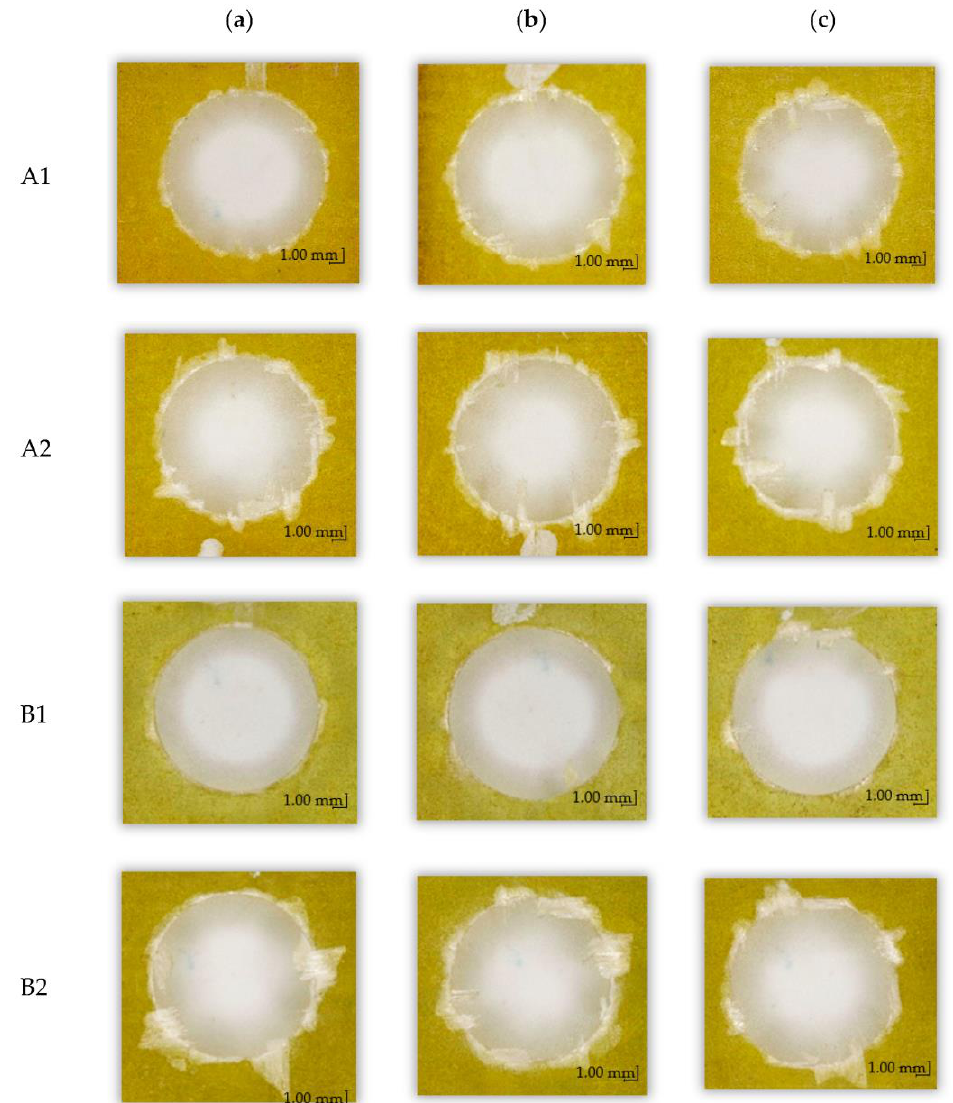
Figure 20. Peel-up delamination images of holes drilled in different GFRPs with a constant feed per tooth f z = 0.016 mm/tooth and different cutting speeds v c : ( a ) 91 m/min, ( b ) 182 m/min, ( c ) 273 m/min.